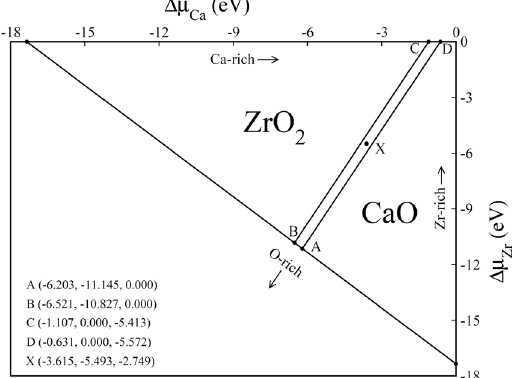
Figure 2. The calculated chemical stability diagram showing the area within which ( Δμ Ca , Δμ Zr , Δμ O ) coordinates represent stable growth of CaZrO 3